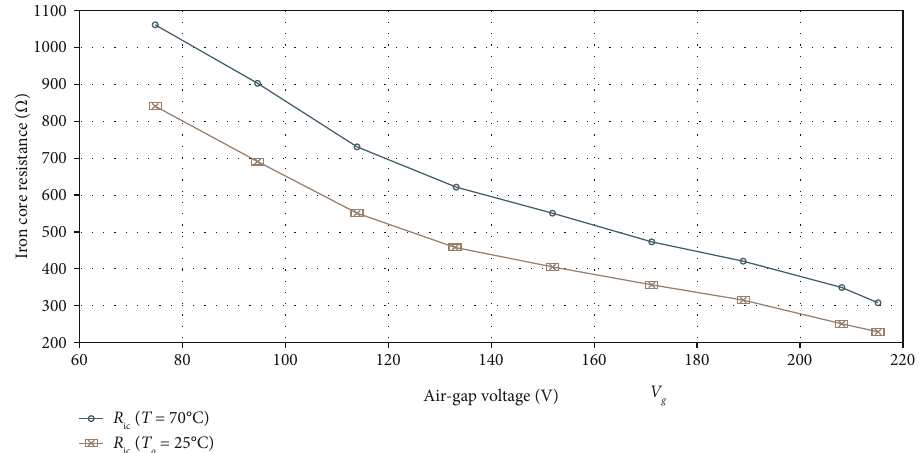
Figure 6: Variation of air-gap voltage with iron core resistance with and without temperature e ff ect.